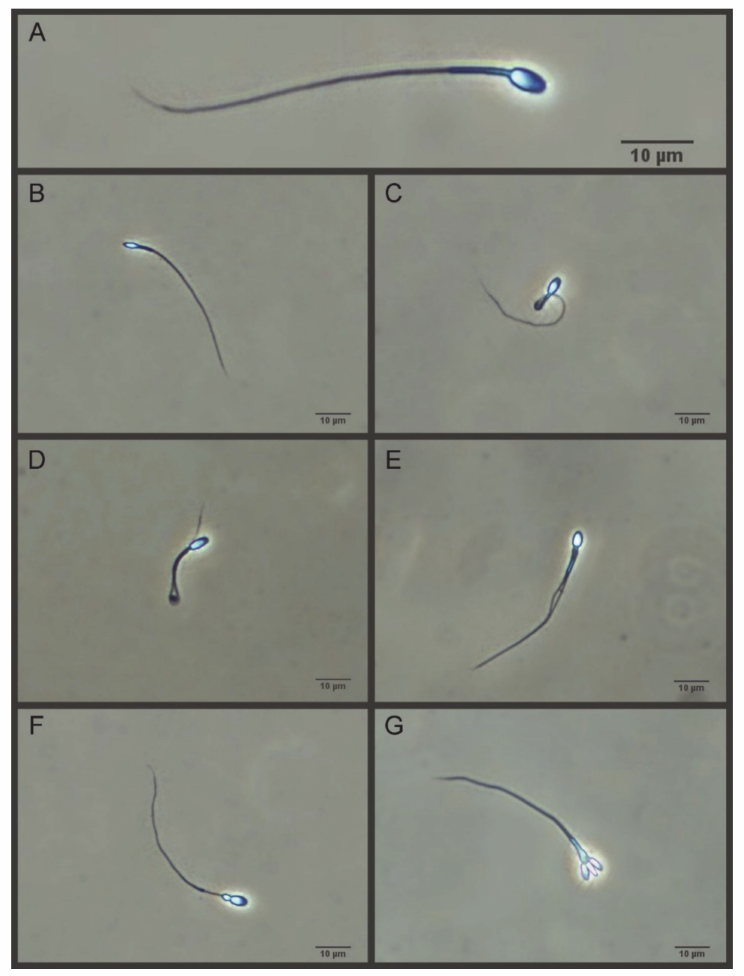
Figure 1. Sperm morphology in the tomcat. ( A ) Normal spermatozoon; ( B ) Head defect; ( C ) Midpiece defect; ( D ) Tail defect; ( E – G ) Multiple defects (40 × phase-contrast